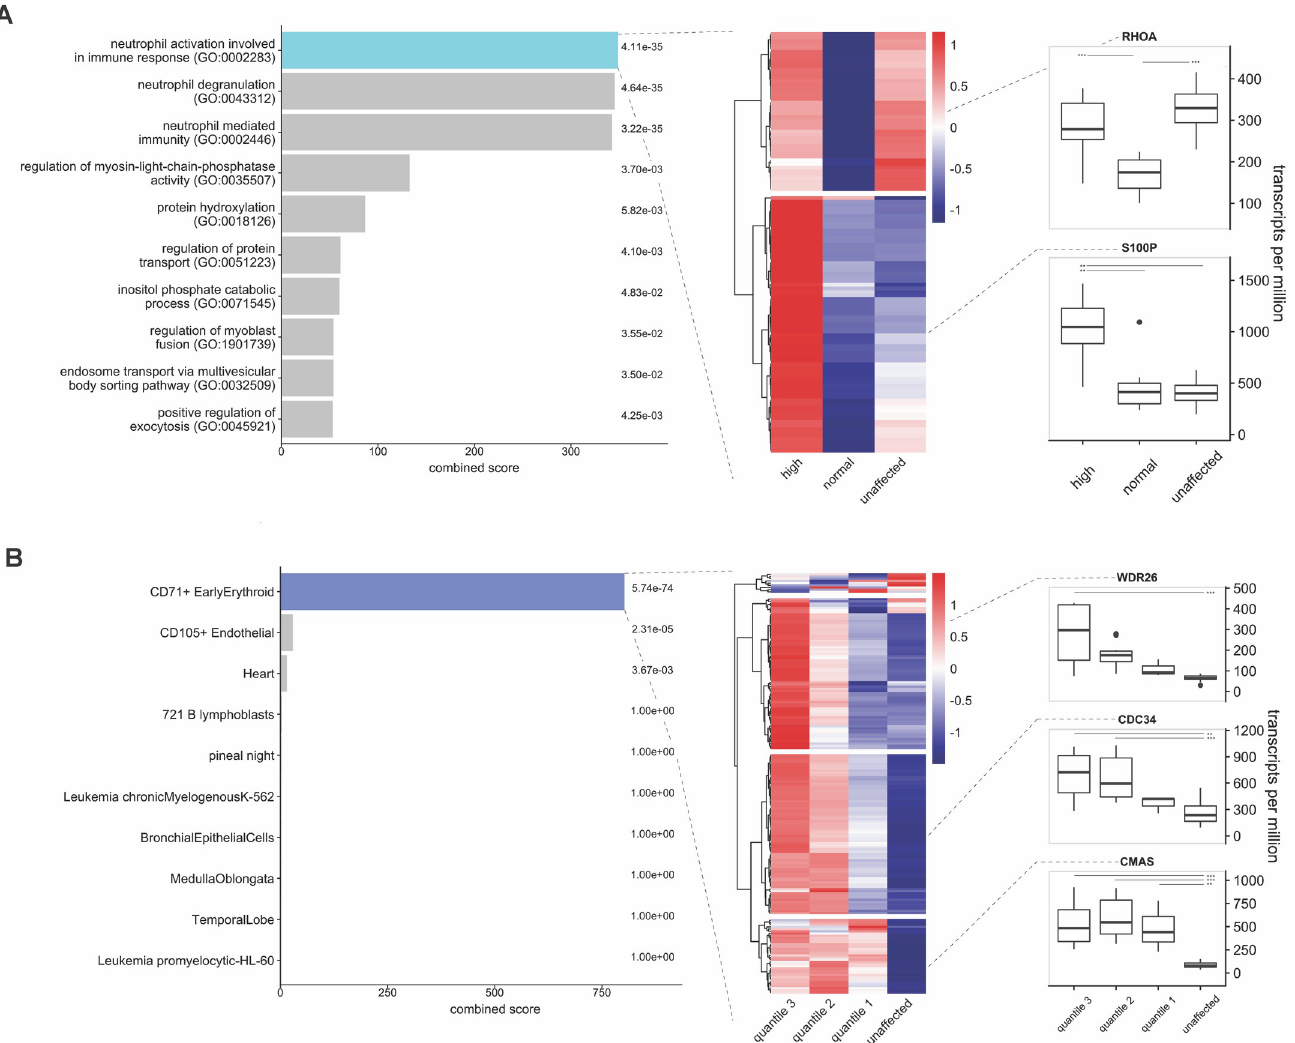
Fig 3. Analysis of WGCNA modules correlated with neutrophil and reticulocyte count. (A) Relationship of cyan module to neutrophil count. Left panel: Pathway analysis of 1,198 genes in the cyan module showing significant overrepresentation of three neutrophil-related pathways. Middle panel: Clustering of gene expression for genes in the top pathway in affected dogs with an elevated neutrophil count ( > 11.2 × 10 3 / μ L; 10 dogs), affected dogs with a normal neutrophil count (8 dogs), and unaffected dogs (18 dogs). Colors show mean, centroid-scaled TPMs. Two distinct gene clusters are present, one containing genes whose expression is increased in affected dogs with an elevated neutrophil count (bottom cluster), and a second containing genes whose expression is decreased in affected dogs with a normal neutrophil count (top cluster). Right panel: Box and whiskers plots showing expression of representative genes from each cluster. (B) Relationship of royal blue module to reticulocyte count. Left panel: Pathway analysis of 1,443 genes in the royal blue module showing significant overrepresentation of an early erythroid pathway. Middle panel: Clustering of gene expression for genes in the top pathway in affected dogs with reticulocyte counts > 300 × 10 6 / μ L (quantile 3; 4 dogs), between 100–300 × 10 6 / μ L (quantile 2; 11 dogs), below 100 × 10 6 / μ L (quantile 1; 3 dogs), and unaffected dogs. Colors show mean, centroid-scaled TPMs. Three distinct gene clusters are present, one containing genes highly expressed in affected dogs in the top reticulocyte quantile (top cluster), one containing genes highly expressed in affected dogs in the top two quantiles (middle cluster), and one containing genes highly expressed in all affected dogs (bottom cluster). Right panel: Box and whiskers plots showing expression of representative genes from each cluster. For both panels, asterisks represent p-values as follows: ��� � 0.0001; �� � 0.001; � �